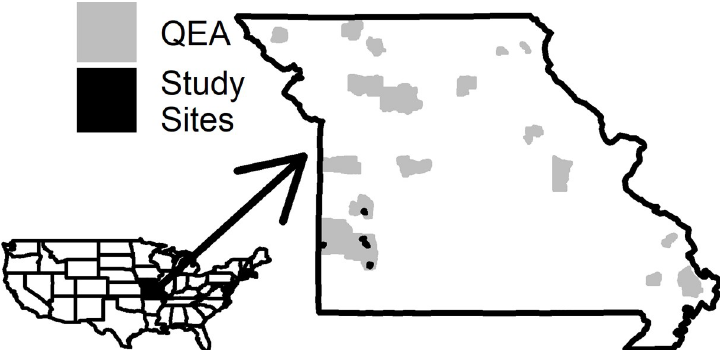
Fig 1. Quail emphasis areas (grey) and study sites (black) where we examined northern bobwhite fall (Nov) and winter (Dec–Jan) resource selection in southwest Missouri, 2017–2019.